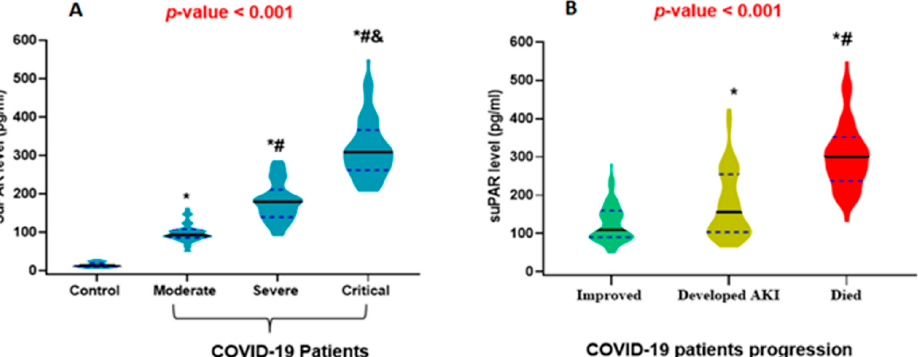
Figure 1. Violin plot demonstrating the median levels of the soluble urokinase plasminogen activator receptor (suPAR): ( A ) COVID-19 patients group compared to control. ( B ) Prognosis of COVID-19. Black lines: indicate the median and blue dots indicate the 25% and 75% quartile. ( Panel A ): * significant com- pared to control, # significant compared to moderate COVID-19, and & significant compared to severe COVID-19. ( Panel B ): * significant compared to improved cases, # significant compared to those who developed AKI and are still alive. One-way ANOVA and post hoc Bonferroni were used to calculate the p -value. Signi fi cance was set at p < 0.05.